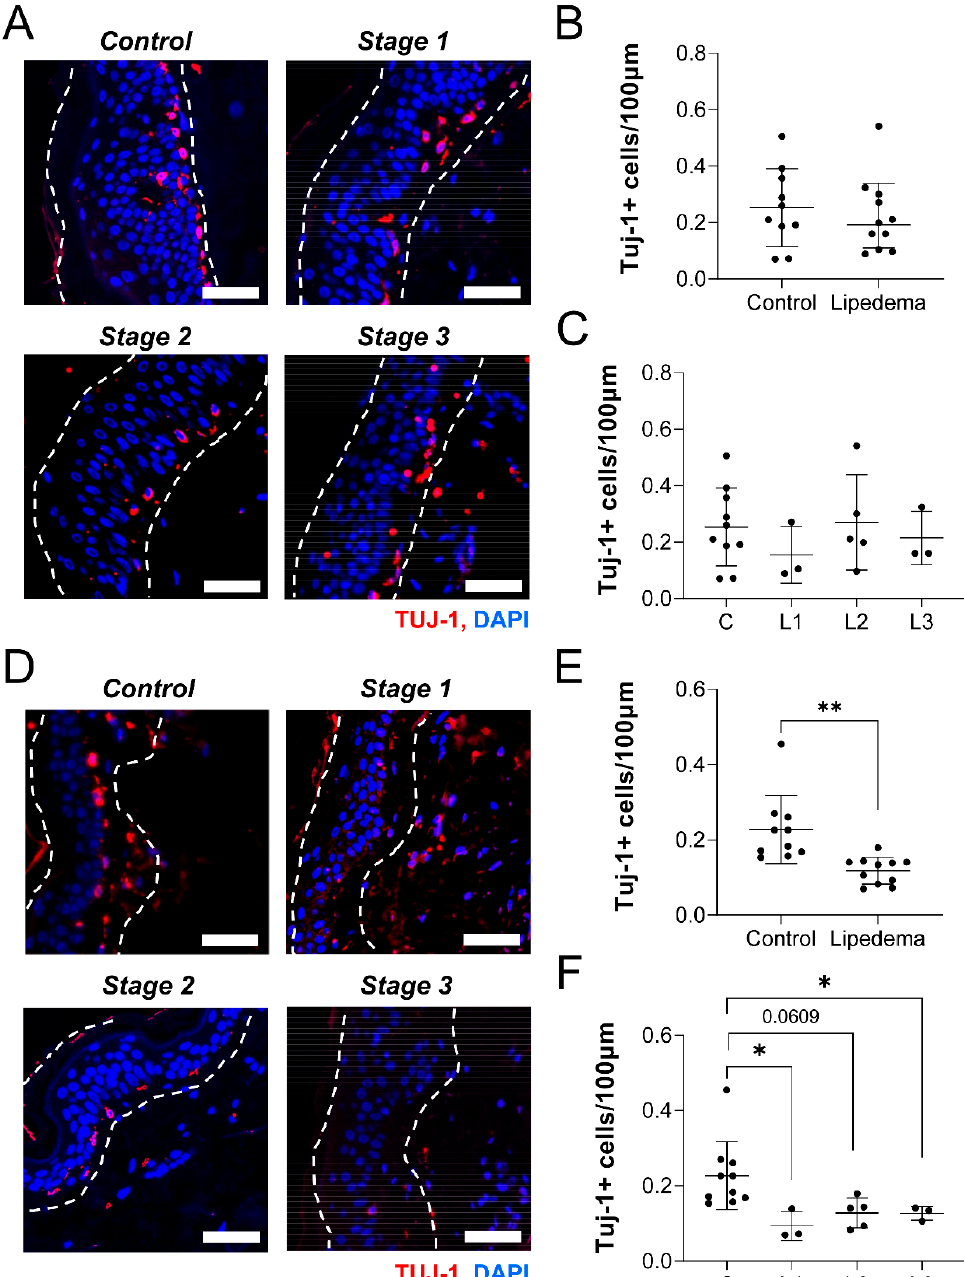
Figure 4. Lipedema stage-based characterization of neuronal cell body distribution in thigh and abdomen dermal sections. ( A ) Tuj1+ (red), nuclei (blue) in thigh dermis of non-lipedema control, 1, 2, and 3 lipedema. ( B ) Comparison between total Tuj1+ (red) cells per 100 nm length of the thigh dermis in control and total lipedema patients. ( C ) Comparison between total Tuj1+ (red) cells per 100 nm length of the thigh dermis in control and stage 1, 2, and 3 lipedema patients ( p = 0.6161 across stages by ANOVA). ( D ) Tuj1+ (red), nuclei (blue) in abdominal dermis of non-lipedema control, and lipedema stages 1, 2, and 3. ( E ) Comparison between total Tuj1+ (red) cells per 100 nm length of the abdominal dermis in control and total lipedema patients. ( F ) Comparison between total Tuj1+ (red) cells per 100 nm length of the abdominal dermis in control and lipedema stages 1, 2, and 3 ( p = 0.0011 across stages by ANOVA). ( A – F ) Control n = 10, Stage 1 n = 3, Stage 2 n = 5, Stage 3 n = 3. Bars = 100 µ m. Mean ± SD. In ( E ), ** indicates p < 0.01; in ( F ) * indicates p < 0.05 by post hoc multiple comparison